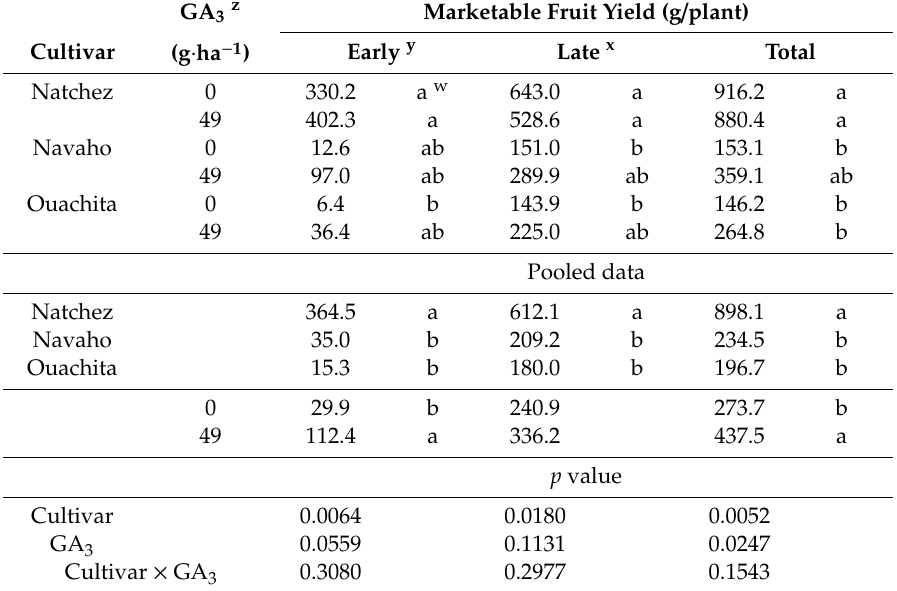
Table 3. E ff ects of gibberellic acid (GA 3 ) treatment on early-, late-, and total-season yield of ‘Natchez’, ‘Navaho’, and ‘Ouachita’ blackberry grown under subtropical climatic conditions in the 2016–2017